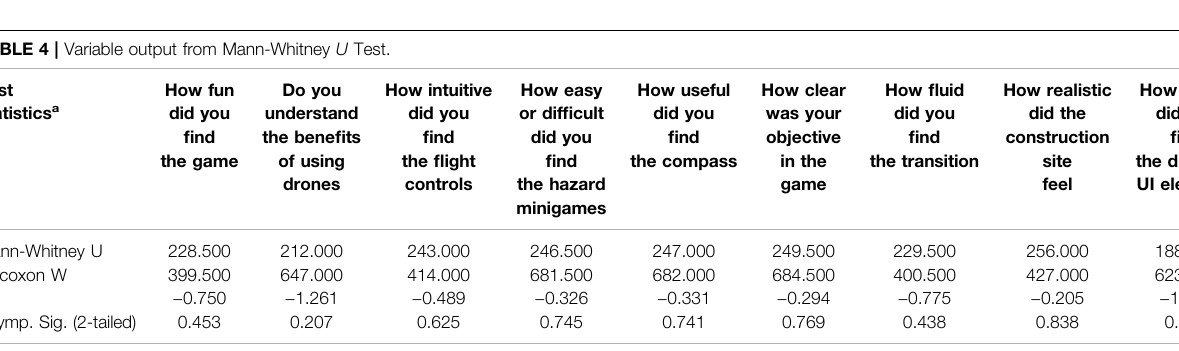
TABLE 4 | Variable output from Mann-Whitney U